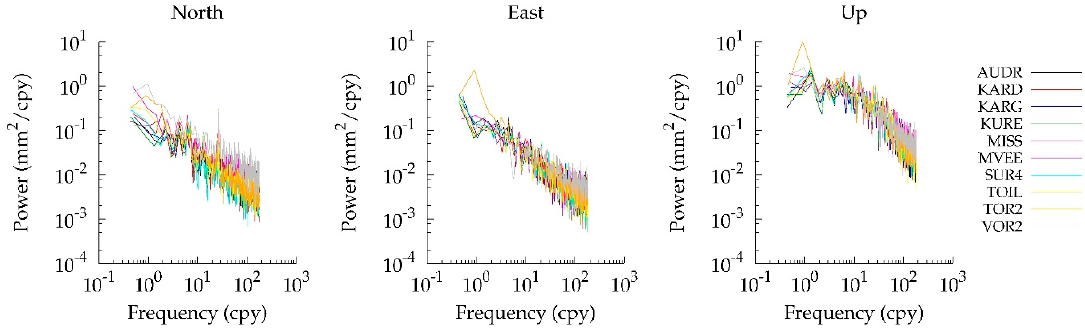
Figure 3. Power spectral densities of the GOA time-series residuals based on the solution GOA_2.